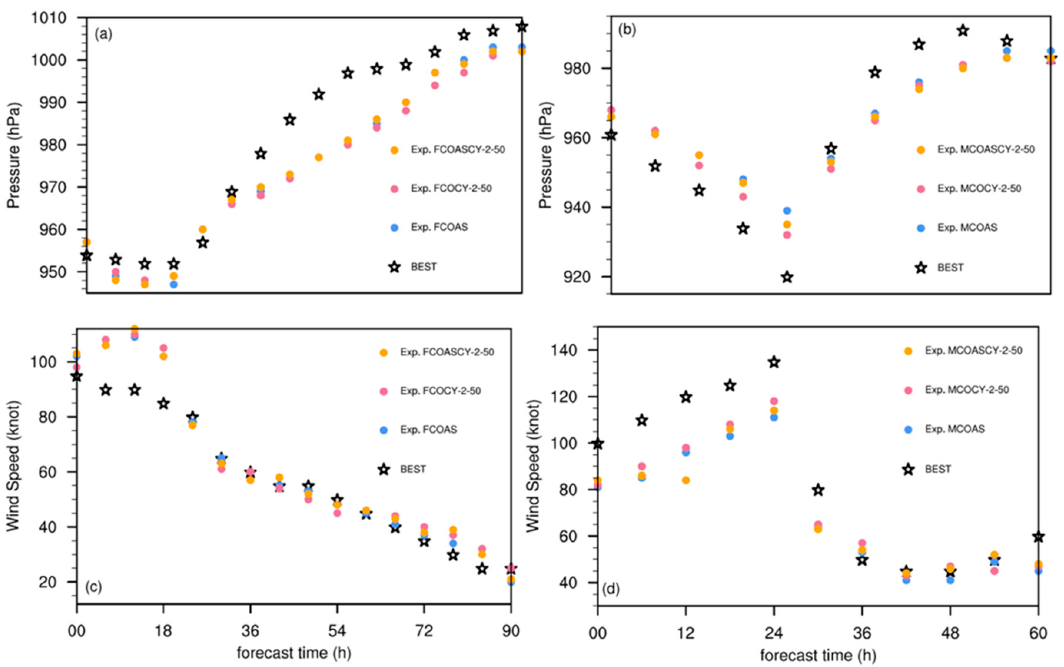
Figure 7. Forecast hurricane intensity for all experiments against the NHC best-track data: ( a ) the minimum hurricane center sea level pressure (MSLP; unit: hPa); ( c ) the maximum surface wind (MSW; unit: knot) for Florence (from 1200 UTC 13 to 0600 UTC on 17 September 2018); ( b ) and ( d ) are MSLP and MWS for Michael (from 1800 UTC 09 to 0600 UTC on 12 October 2018), respectively. X axis is forecast time (unit: h).